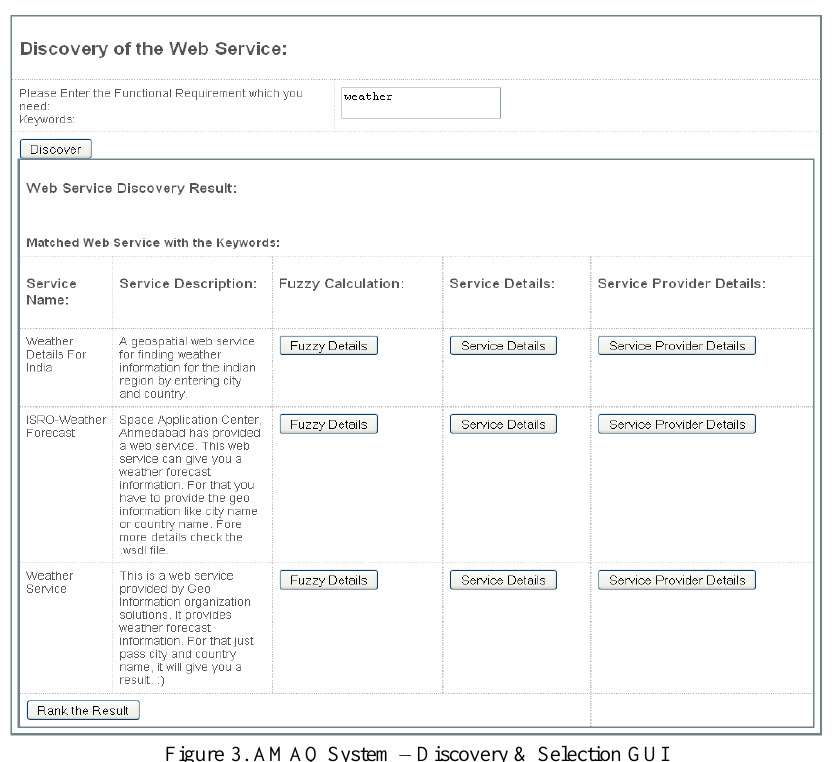
Figure 3. AMAQ System – Discovery & Selection GUI